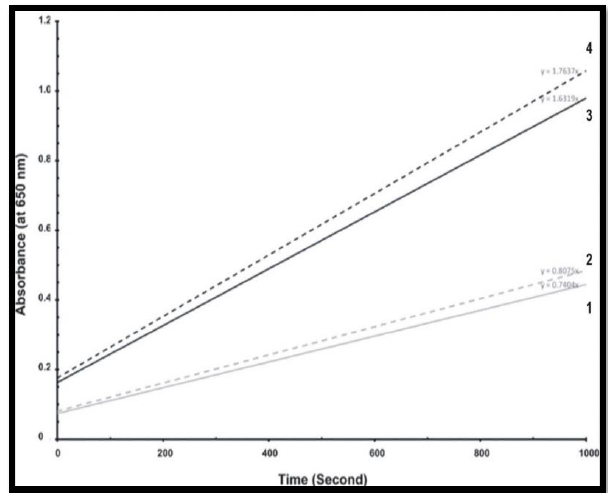
Fig. 9. Steady-state kinetic assay of G-quadruplex insulin aptamers. 1) non-conjugated aptamers. 2) conjugated aptamers on the surface of MNP, 3) DNTs with extrior MNP and 4) DNTs with interior MNP .